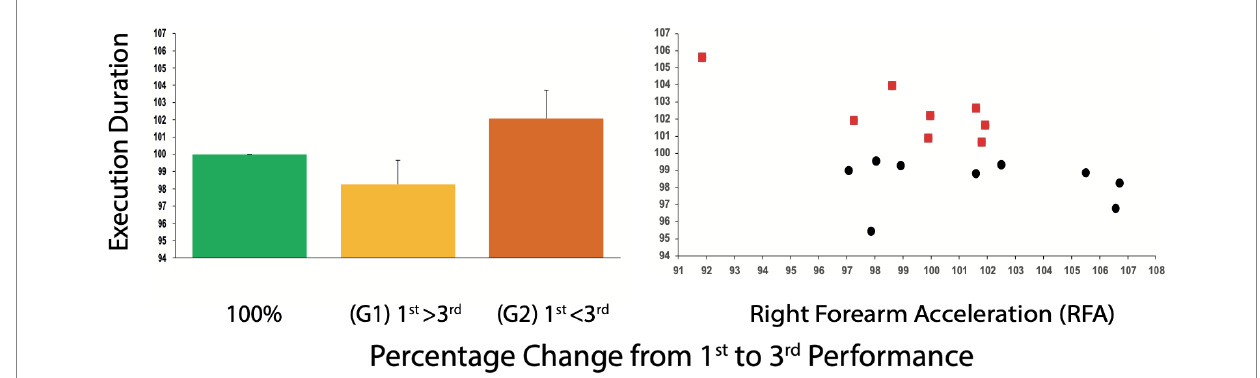
FIGURE 4 Changes in Overall Execution Duration (left) and Percentage Change in Right Forearm Acceleration (right), from 1st to 3rd performance. One group played faster (G1 n = 9) the other group (G2 n = 8) played slower during the 3rd performance (left) . 100% is shown for clarity, as a reference. On the right side, all participants split according to relative execution duration correlated to percentage changes in right forearm acceleration. Red squares represent G2 (longer execution duration at the 3rd